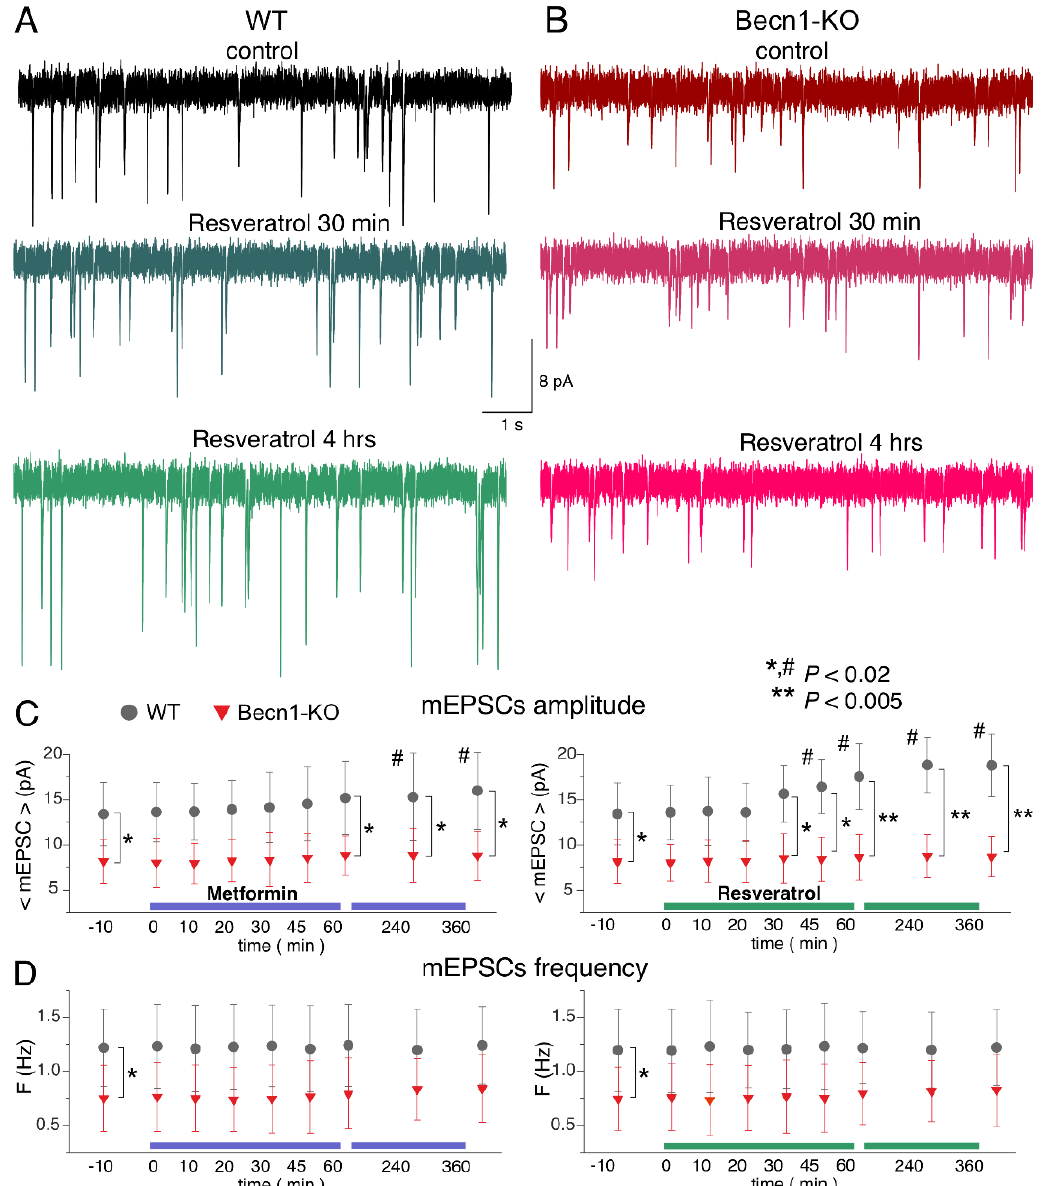
Figure 6. Effects of autophagy modulators on excitatory synaptic transmission in the neocortical neurons. The glutamatergic mEPSCs were recorded as in Figure 3. ( A , B ) The representative mEPSCs recorded in the neurons of the Becn1 +/+ ( A ) and Becn1 +/ − ( B ) mice in the control (top row) and after application of metformin (5 µ M) for 30 min (middle row, the same neuron as in the control) and 4 h (bottom row); the same scale applies for all panels. Note the significant increase in the mEPSC amplitude in the WT neuron after 4 h-long application of metformin. ( C , D ) Each dot shows the average amplitude and frequency of spontaneous currents recorded in a 2 min time window in the pyramidal neurons of the wild-type and Beclin1-deficient mice during the application of metformin (5 µ M) and resveratrol (20 µ M). The drugs were applied at the zero time point; data are presented as means ± SDs for nine neurons. The asterisks (* or **) indicate the statistical significance of the differences between the Becn1 +/+ and Becn1 +/ − mice. The hash symbols (#) indicate the statistical significance of the effects of the drugs as compared to the neuron of the same genotype in the control. Decrease in the amplitude of mEPSCs was observed in the wild-type but not in the Beclin1-deficient